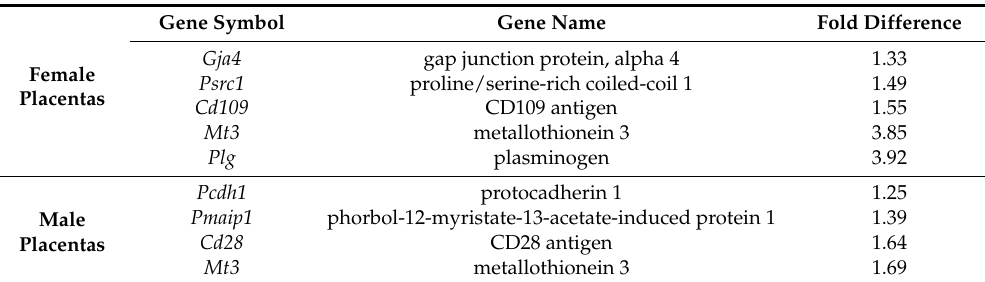
Table 4. Predicted mRNA targets of miR-2137 that displayed upregulation in the female and male placentas in response to 4X choline supplementation 1 − 3